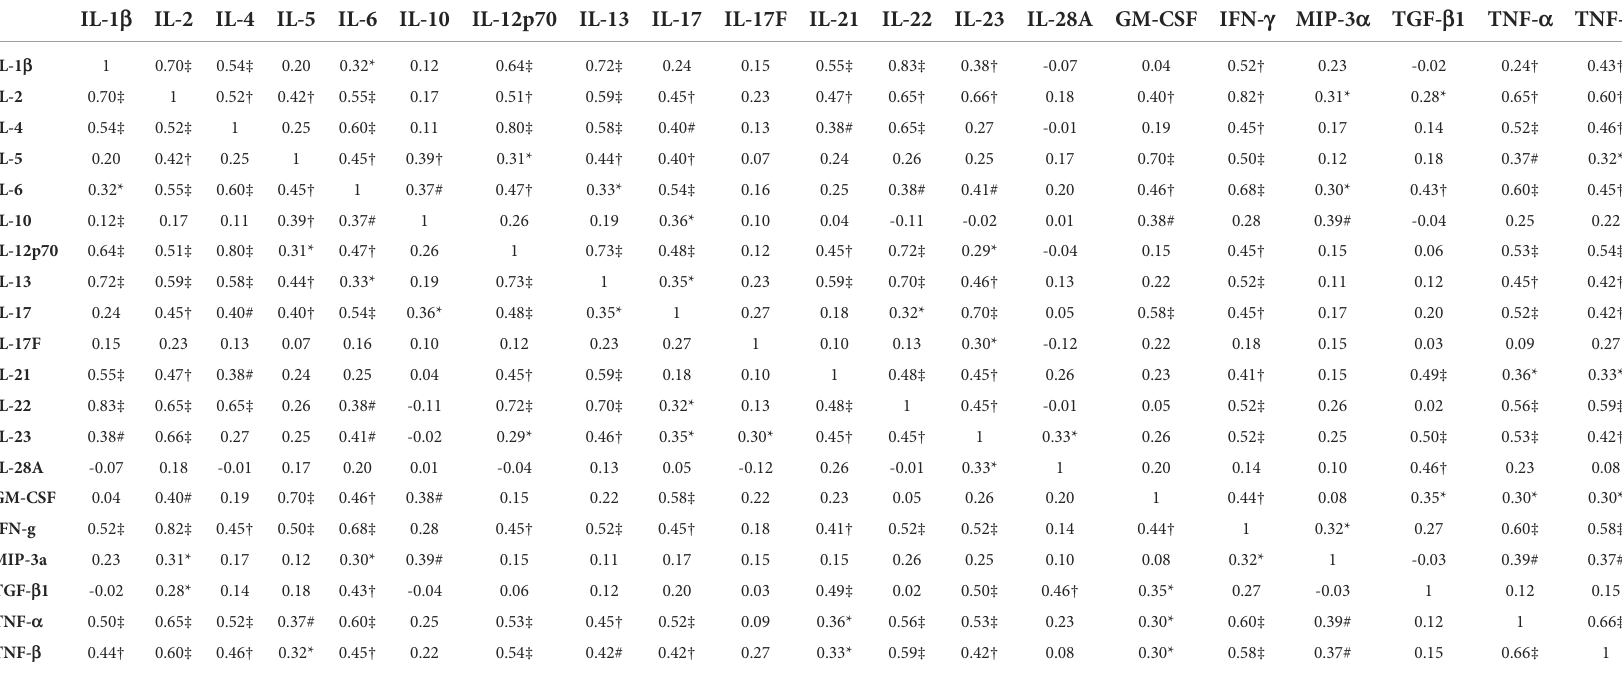
TABLE 3 Correlation